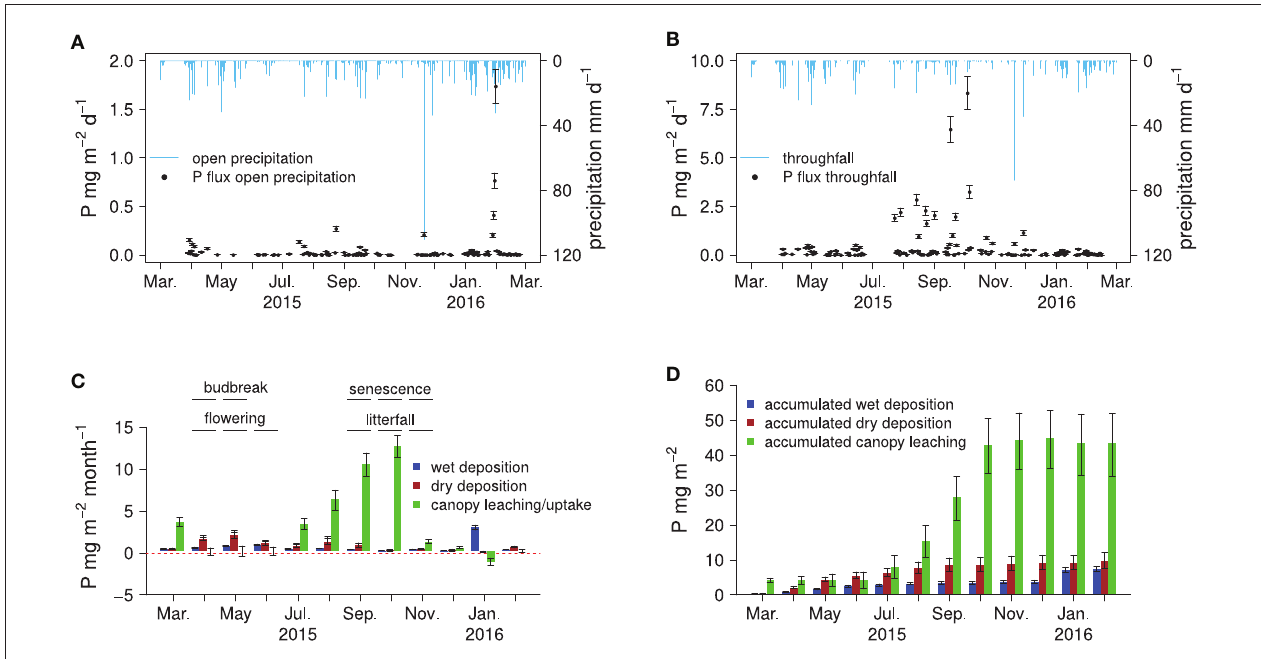
FIGURE 2 | Fluxes of P in bulk precipitation and throughfall, monthly, and accumulated atmospheric P deposition to the forest floor: daily fluxes of P in open precipitation (A) and throughfall (B) , the canopy P balance with monthly fluxes of wet deposition, dry deposition, canopy leaching, and some phenological indicators measured on site (C) , and accumulated fluxes of P in wet deposition, dry deposition, and canopy leaching (D)